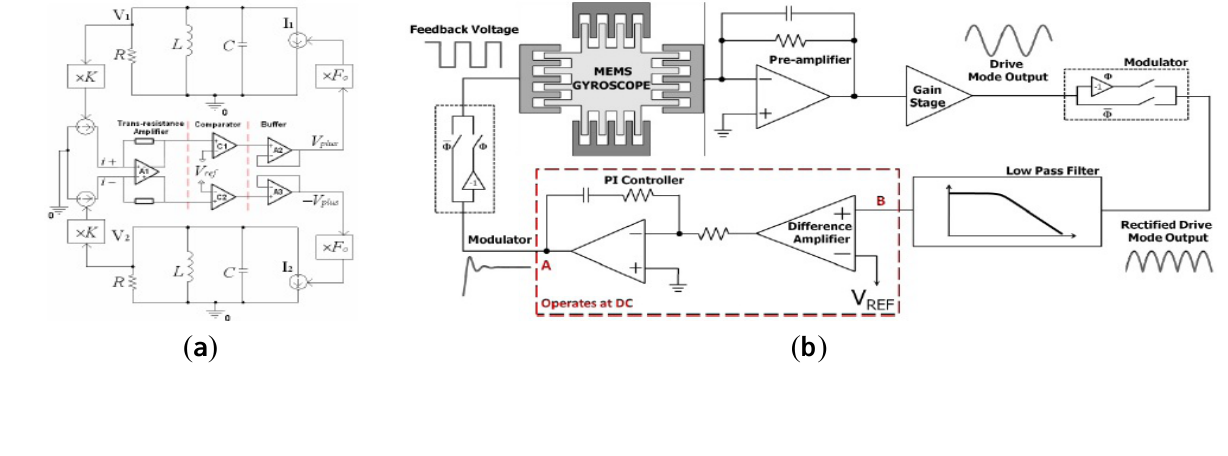
Figure 30. ( a ) Harbin Institute of Technology driving circuitry. ( b ) Middle East Technical University driving